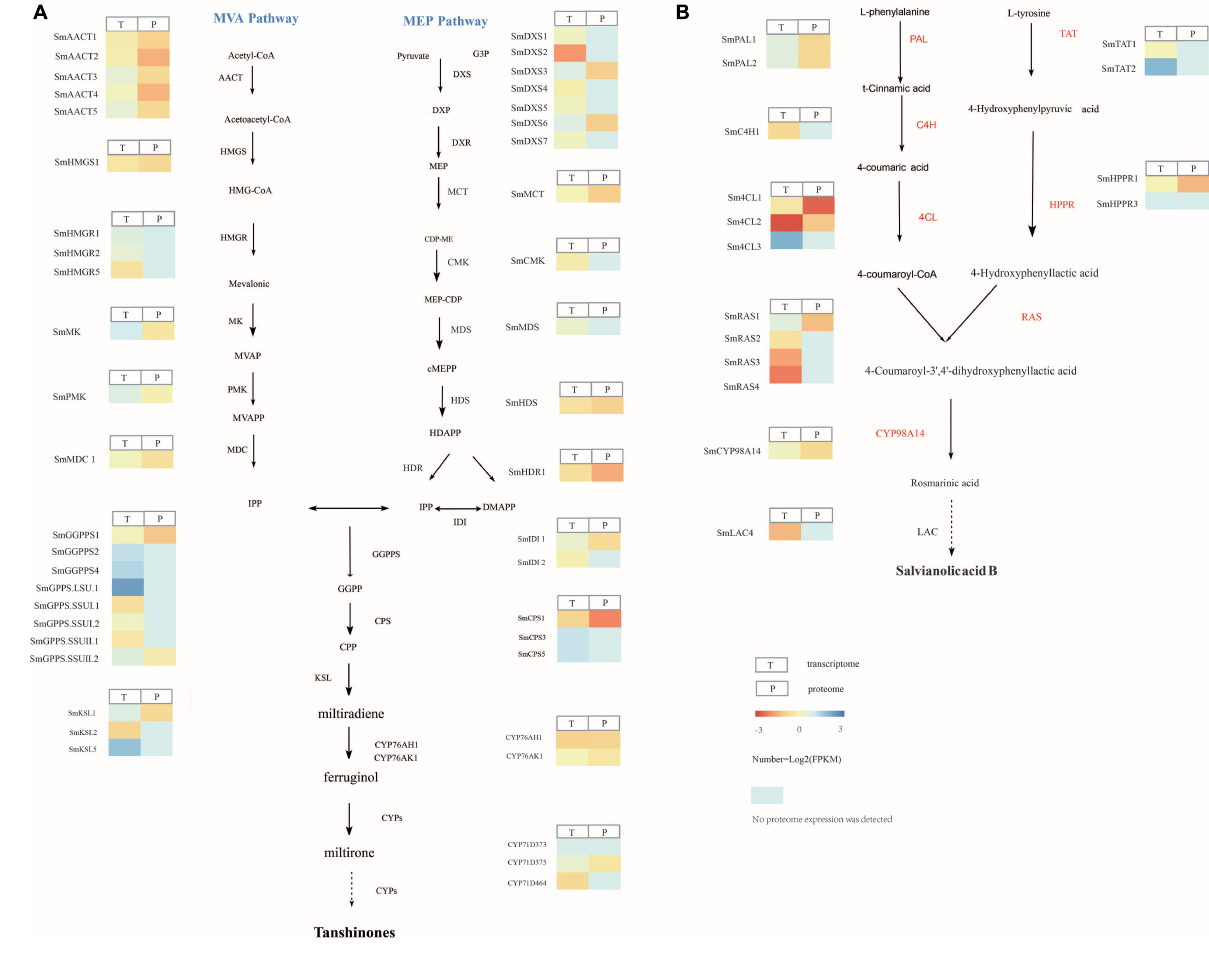
Frontiers in Plant Science |